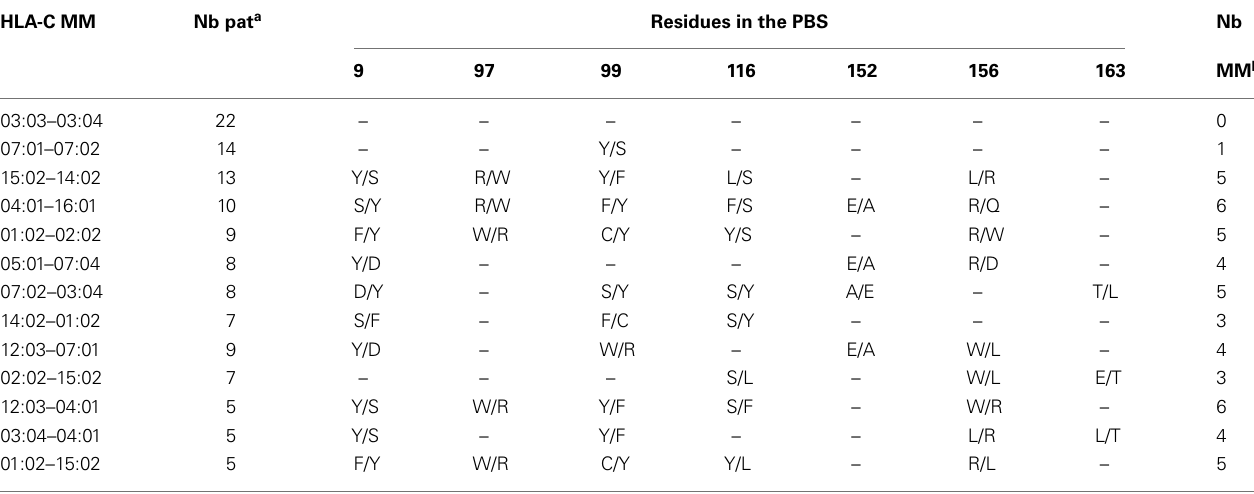
Table 3 | Substitutions in the peptide-binding site (PBS) associated with outcome (3, 24, 32) in 13 frequent HLA-C mismatches as reported in Ref. (28)